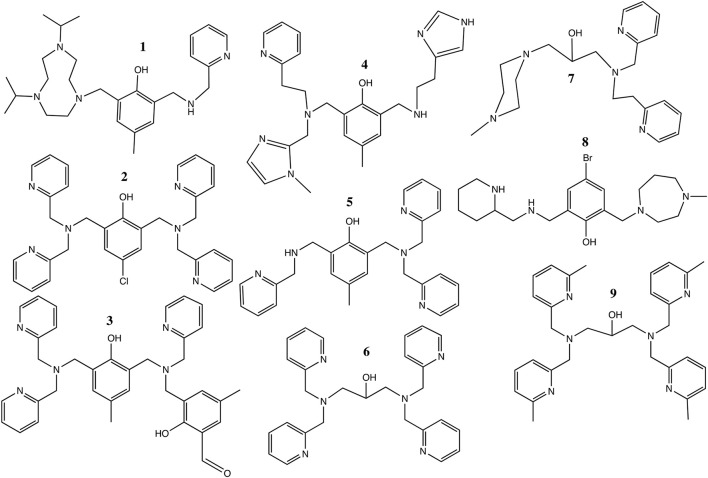
The ligands listed in Table 3.